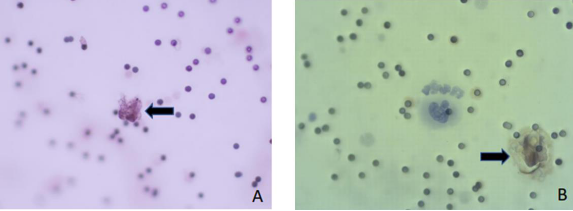
Figure 3. Cells were analyzed based on morphological characteristics or immunological features (magnification, ×400) ( A ); isolated cells stained with anti-pan-CK antibodies (brown; magnification, ×400) ( B ).